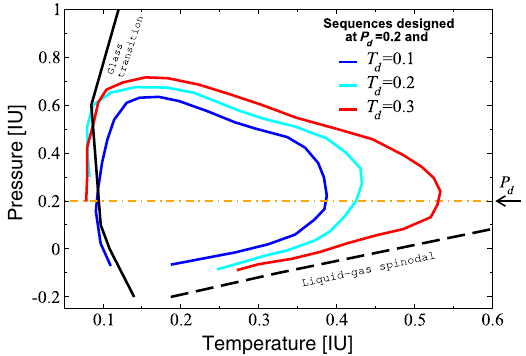
FIG. 5. Average stability regions for proteins designed at constant pressure according to the MIN ENTHALPY protocol. The proteins are designed along the isobar P d ¼ 0 . 2 IU. We observe how designed sequences at high T d are more resistant to thermal fluctuations.